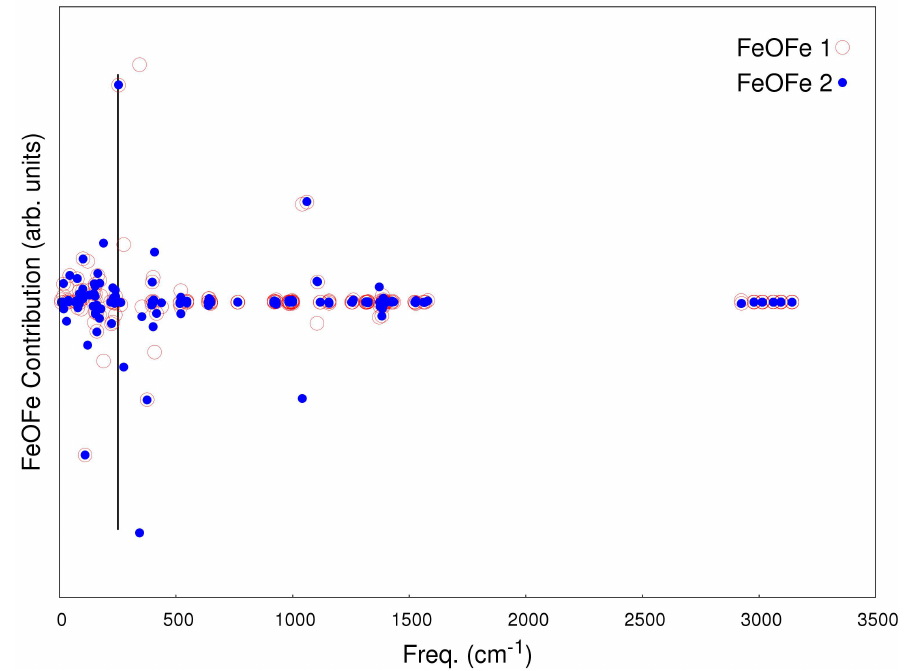
Figure 2. Contribution to normal modes of the two FeOFe bending internal displacements as function of frequencies. The solid black vertical line at ∼ 250 cm − 1 points to the contribution of the symmetric double FeOFe bending chosen as normal mode reference